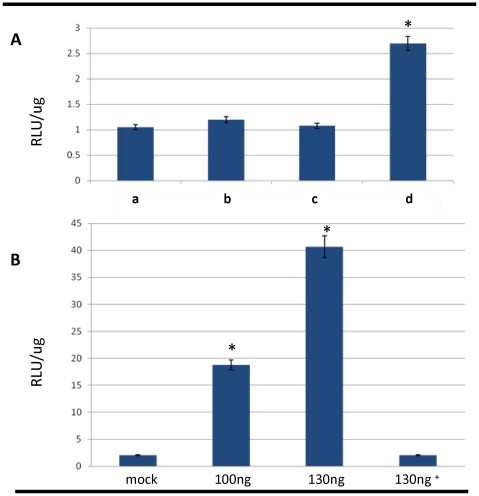
Luciferase activity in Schistosoma mansoni eggs.Detection of luciferase activity in extracts of eggs treated with capped mRNA encoding firefly luciferase (mFLuc). Panel A: luciferase activity three hours after soaking or electroporation with 130 ng/µl of mFLuc; a, negative controls soaked without mFLuc; b, eggs soaked with mFLuc; c, negative control eggs electroporated without mRNA; d, eggs electroporated with mFLuc. RLUs/µg, relative light units per microgram of egg protein. Panel B: luciferase activity three hours after electroporation of eggs in control (mock) and experimental groups with 100ng/µl and 130ng/µl of mFLuc, and at 30 hours after electroporation with 130 ng/µl (indicated with cross symbol). Asterisks denote statistically significant differences (P≤0.05) among groups.